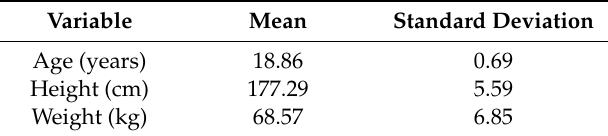
Table 4. General characteristics of the study